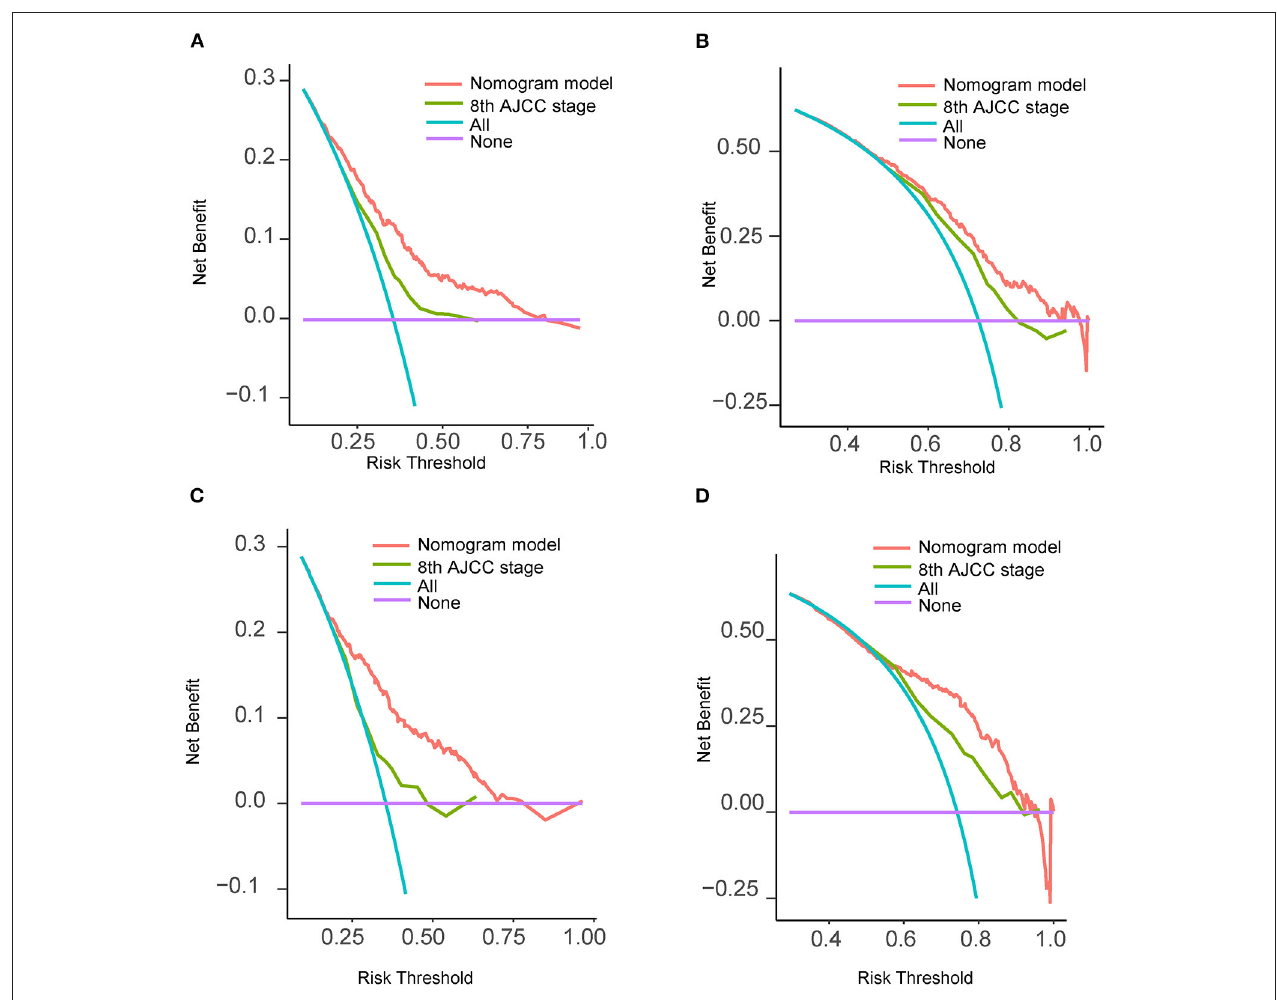
FIGURE 5 | Decision curves analysis and comparison of the nomogram with the 8th AJCC TNM staging system. (A) 1-year OS in the training cohort; (B) 3-year OS in the training cohort; (C) 1-year OS in the validation cohort; (D) 3-year OS in the validation cohort. AJCC, American Joint Committee on Cancer; OS, overall survival; TNM, tumor-node-metastasis.